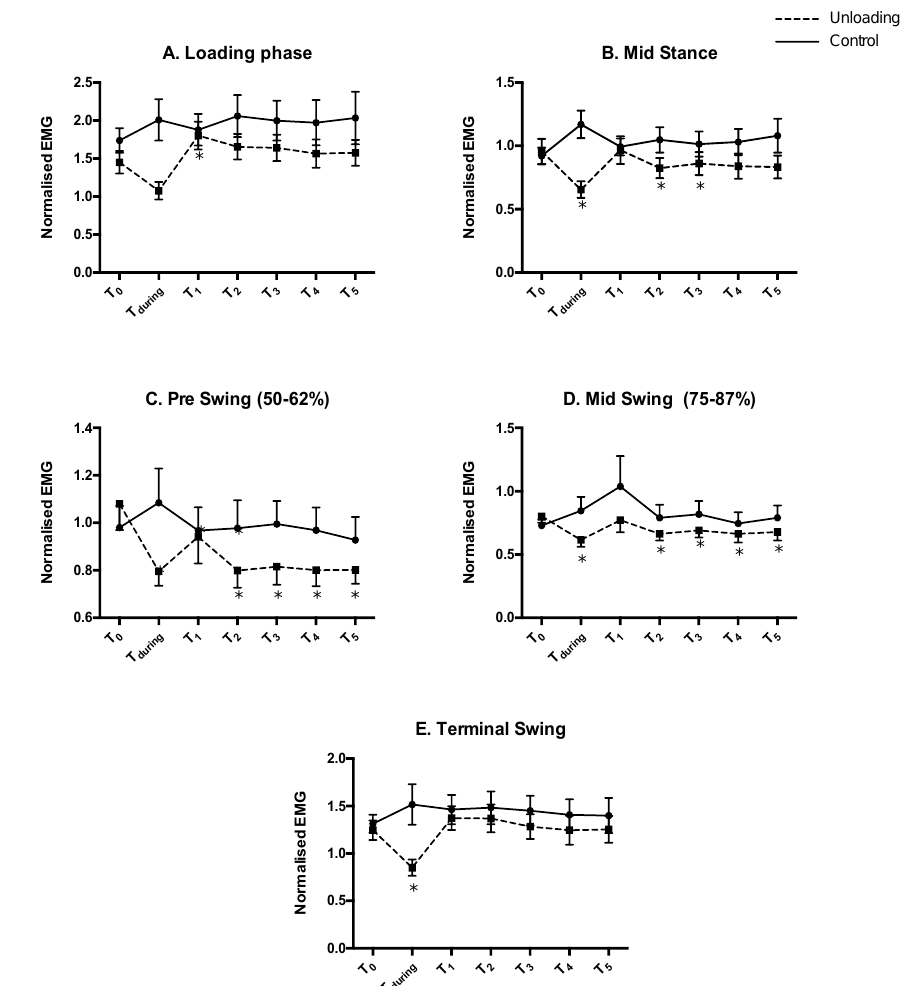
Figure 7. Group means ( SEM) of EMG activity of the rectus femoris (RF) muscle across different epochs during the ( A ) loading, ( B ) mid-stance, ( C ) pre-swing, ( D ) mid-swing, and ( E ) terminal swing phases for control and unloading conditions. * Significant difference ( p < 0.05) relative to T 0 of the corresponding condition.